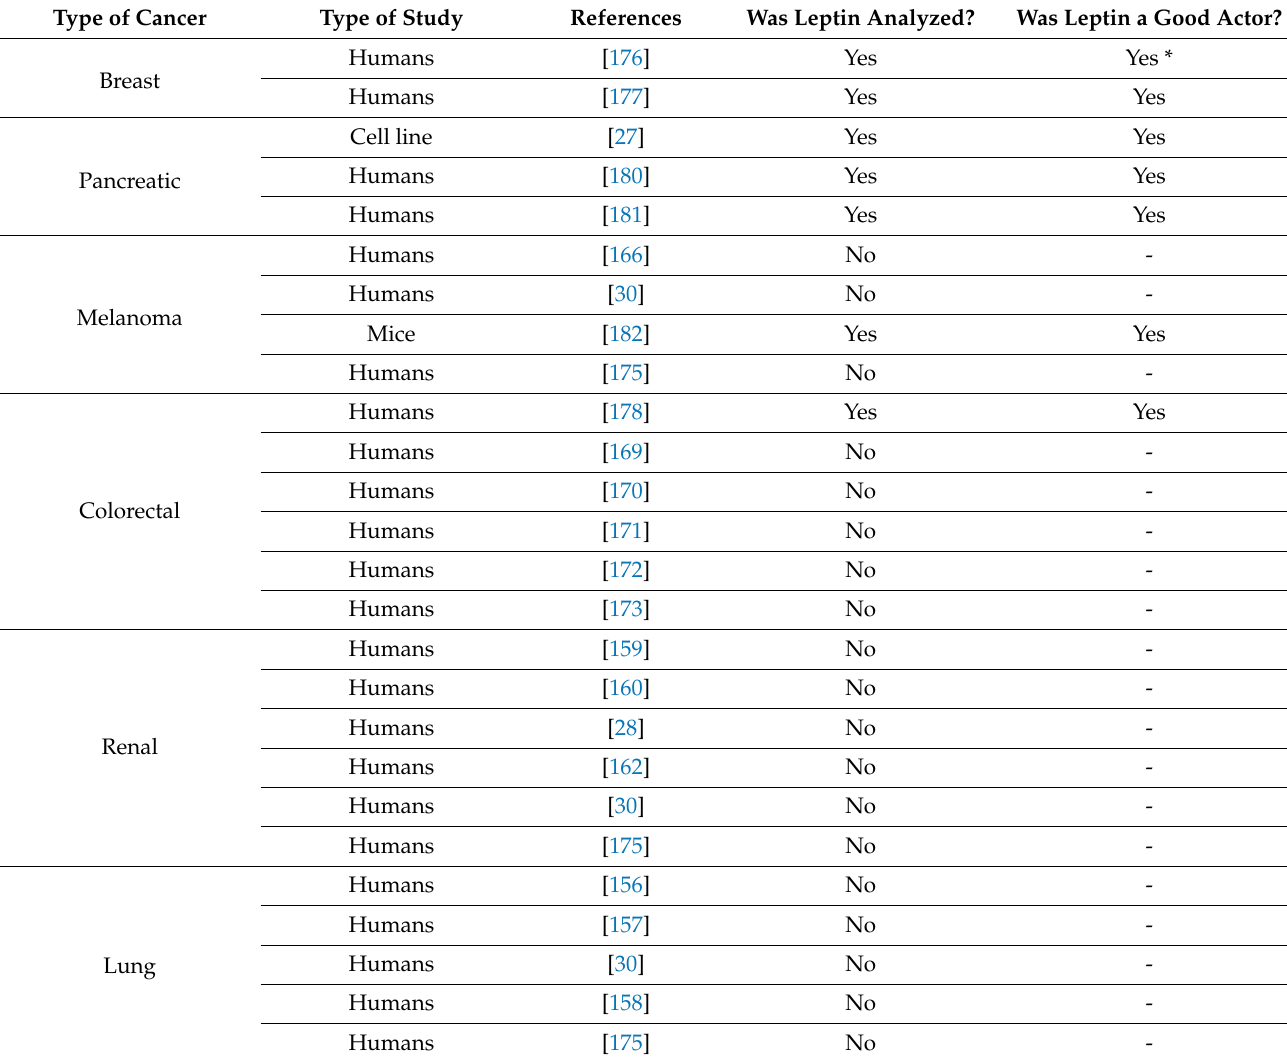
Table 1. Reviewed studies in which obesity plays a favorable role in cancer and those in which leptin behaves as a good actor. Type of